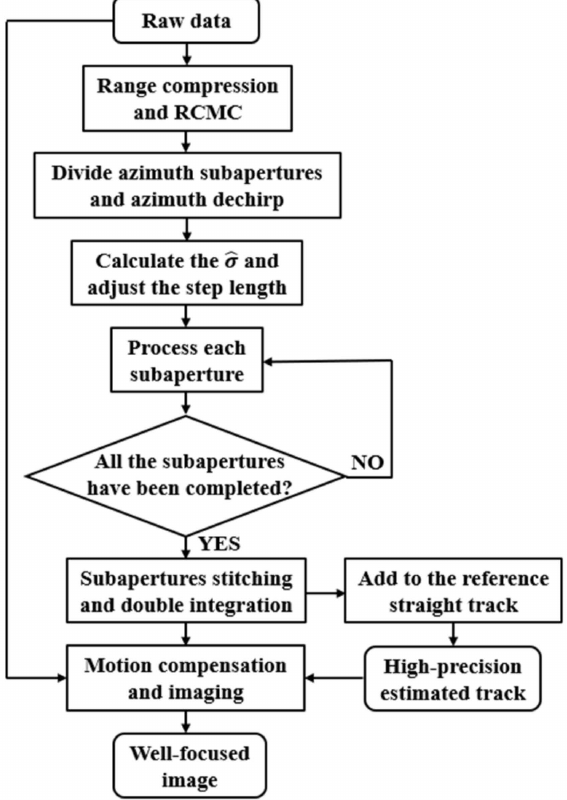
Figure 7. The overall process of track error